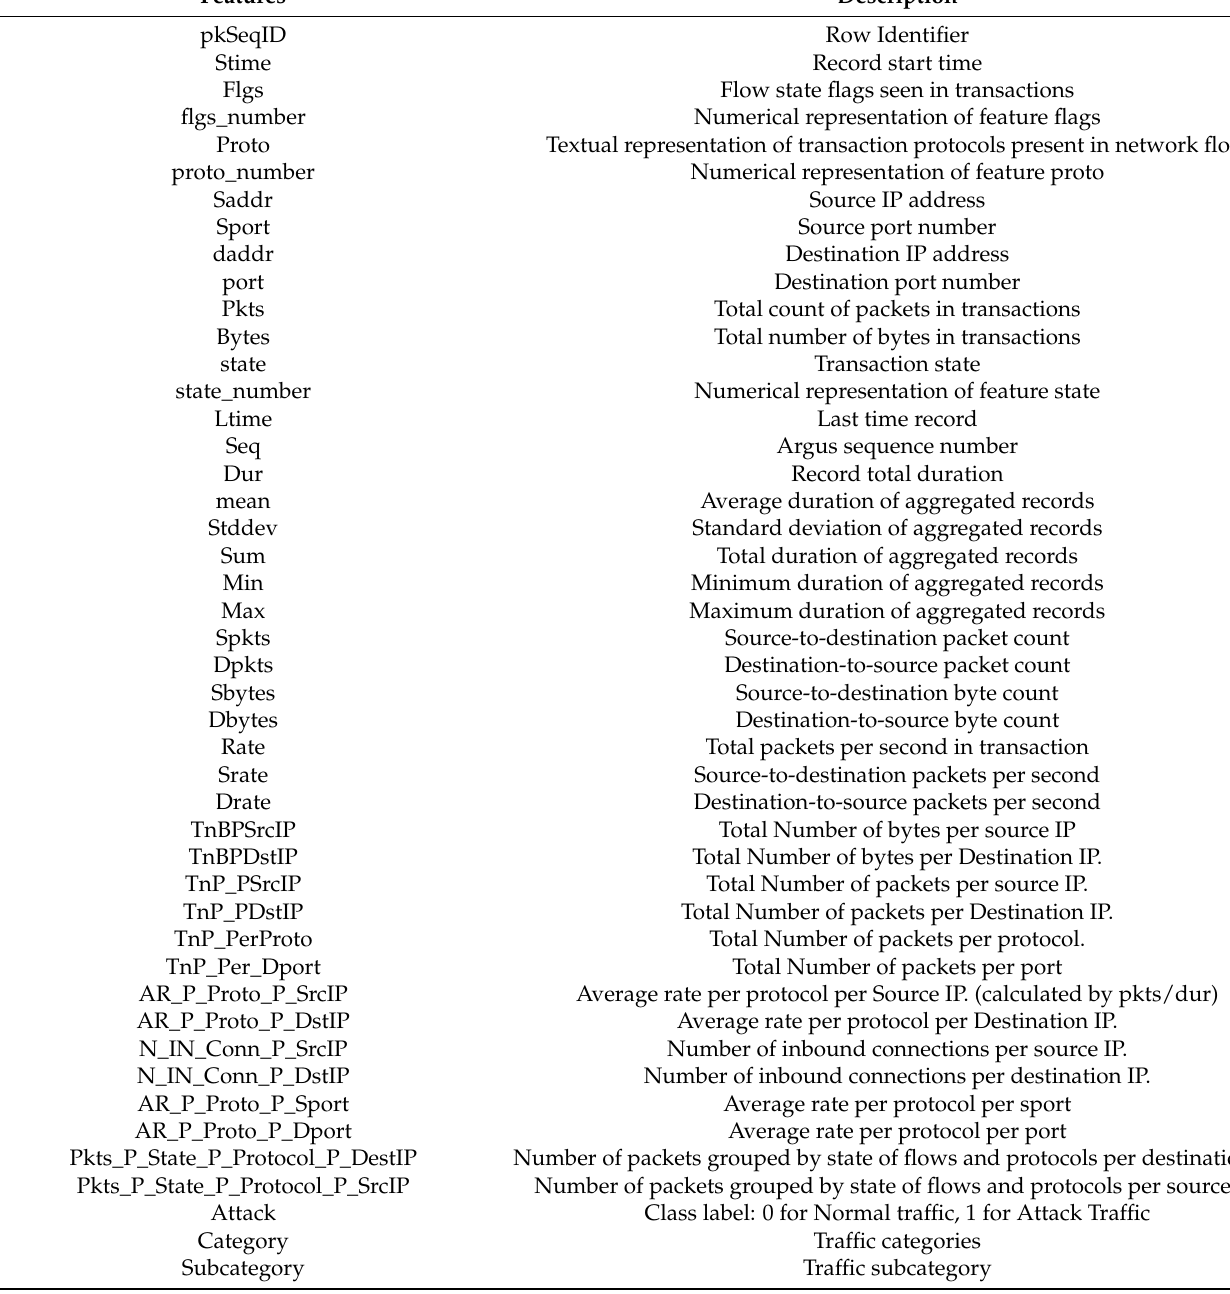
Table 1. Dataset and its